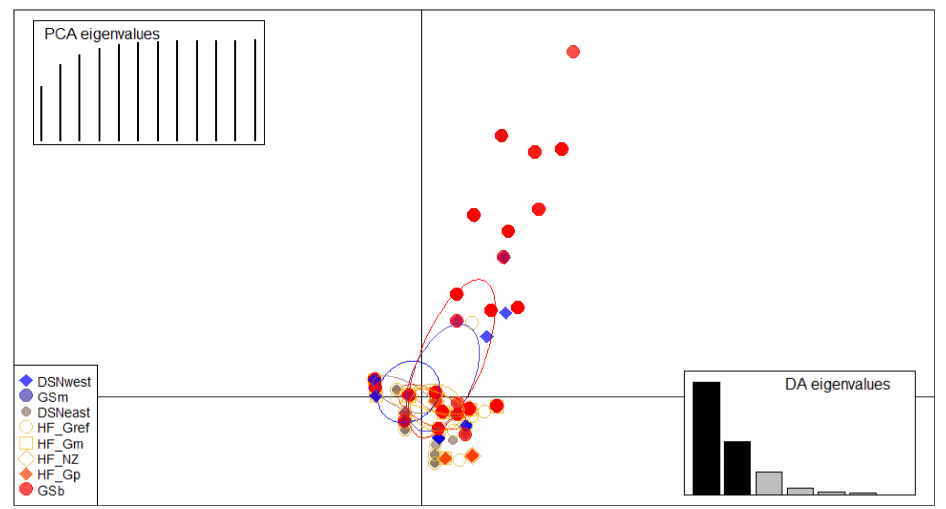
Figure 2. Scatterplot of the discriminant analysis of principal components (DAPC) based on casein haplotype frequencies. Eight selection lines are plotted according to the eigenvectors corresponding to the first (56%) and second (27%) linear discriminants. Each circle represents a cluster and each dot represents an